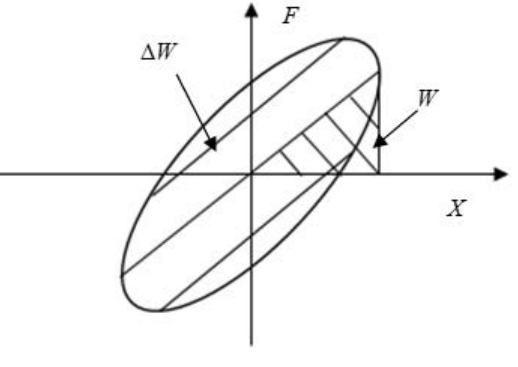
Figure 8. Hysteresis